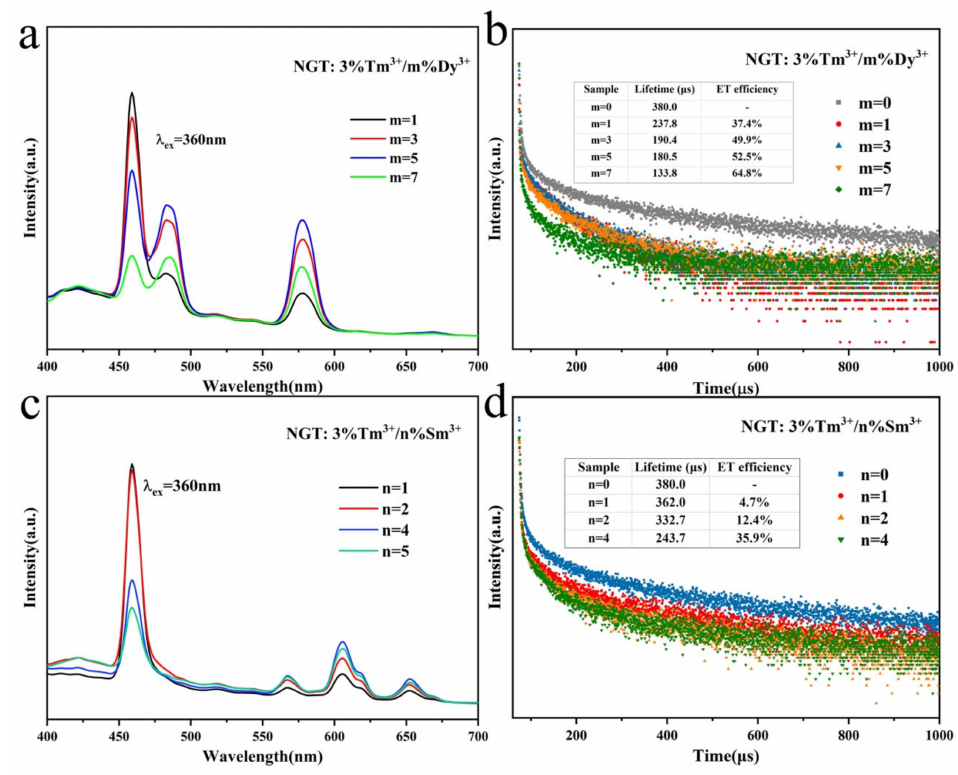
Figure 4. ( a , c ) PL emission spectra of NGT: 3%Tm 3 + / m %Dy 3 + and NGT: 3%Tm 3 + / n %Sm 3 + phosphors; ( b , d ) decay curves of NGT: 3%Tm 3 + / m %Dy 3 + and NGT: 3%Tm 3 + / n %Sm 3 + phosphors monitored at 459 nm and excited at 360 nm; the inset tables show their average lifetimes and energy transfer (ET) e ffi